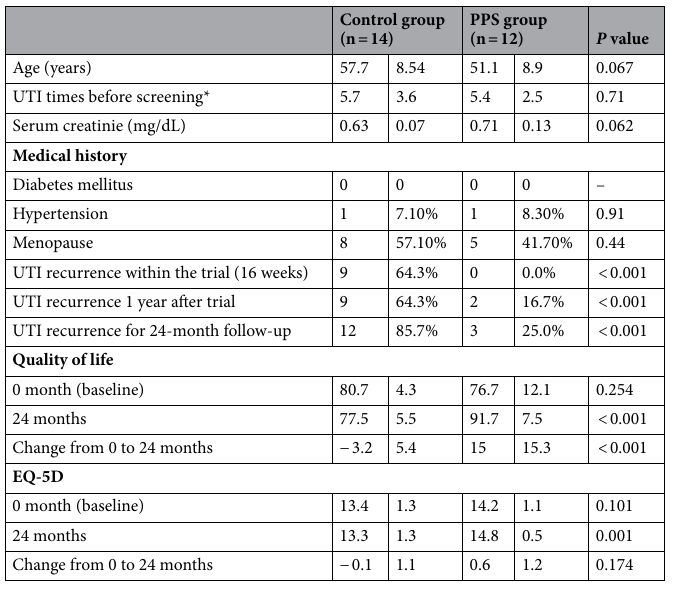
Table 1. Demographic, clinical characteristics and outcomes of patients with recurrent UTI. Data are mean (SD); or n (%). *Statistical analyses were carried out using Student’s t-test to compare means between the patient groups.